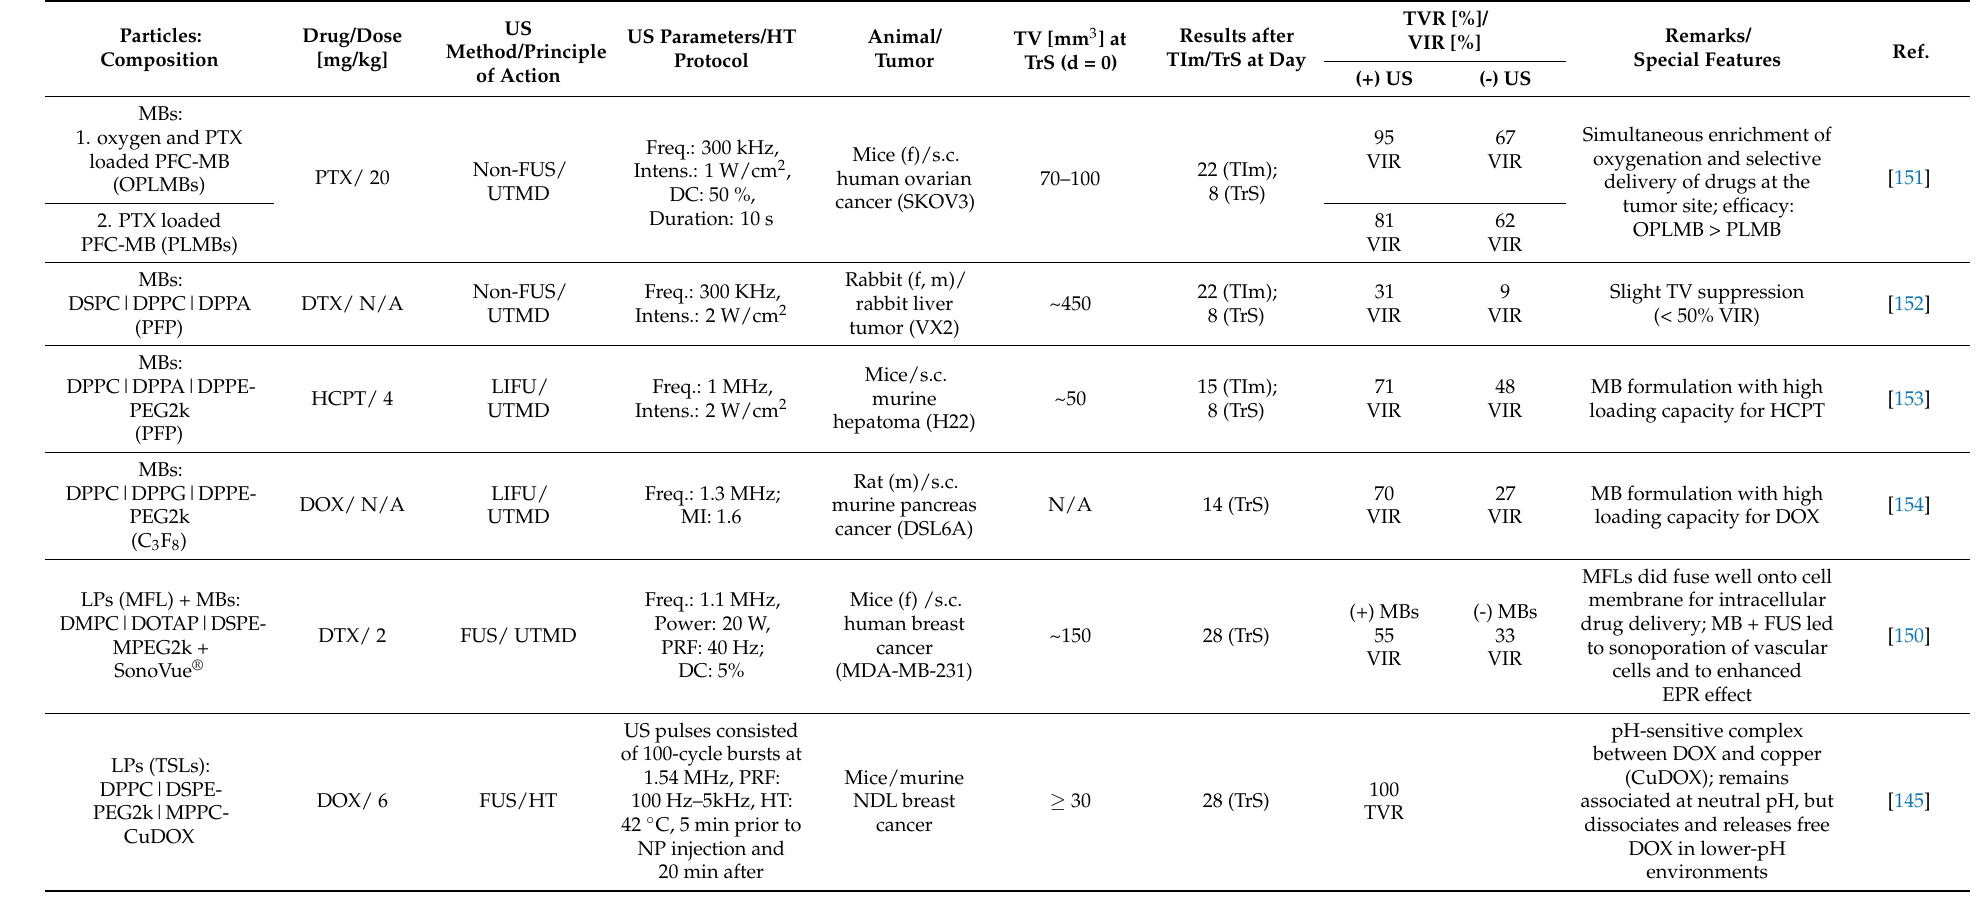
Table 3. Therapeutic outcome of in vivo studies using different modalities in US-mediated drug